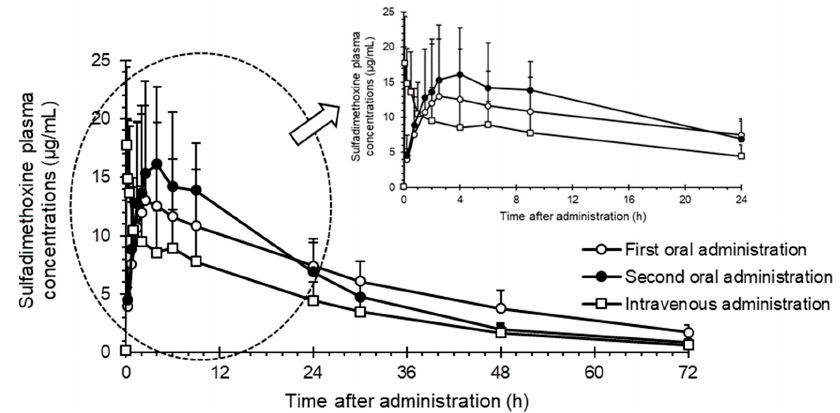
Figure 1. Sulfadimethoxine (SDM) plasma concentrations (mean ± SD) after single administrations of a SDM-trimethoprim (TMP) combination orally (Trisulmix ® Liquid, 24.7 mg / kg SDM + 5.3 mg / kg TMP, open circles = first oral administration, closed circles = second oral administration) or intravenously (Trisulmix ® Injectable, 24.7 mg / kg SDM + 5.3 mg / kg TMP, open squares) to eight